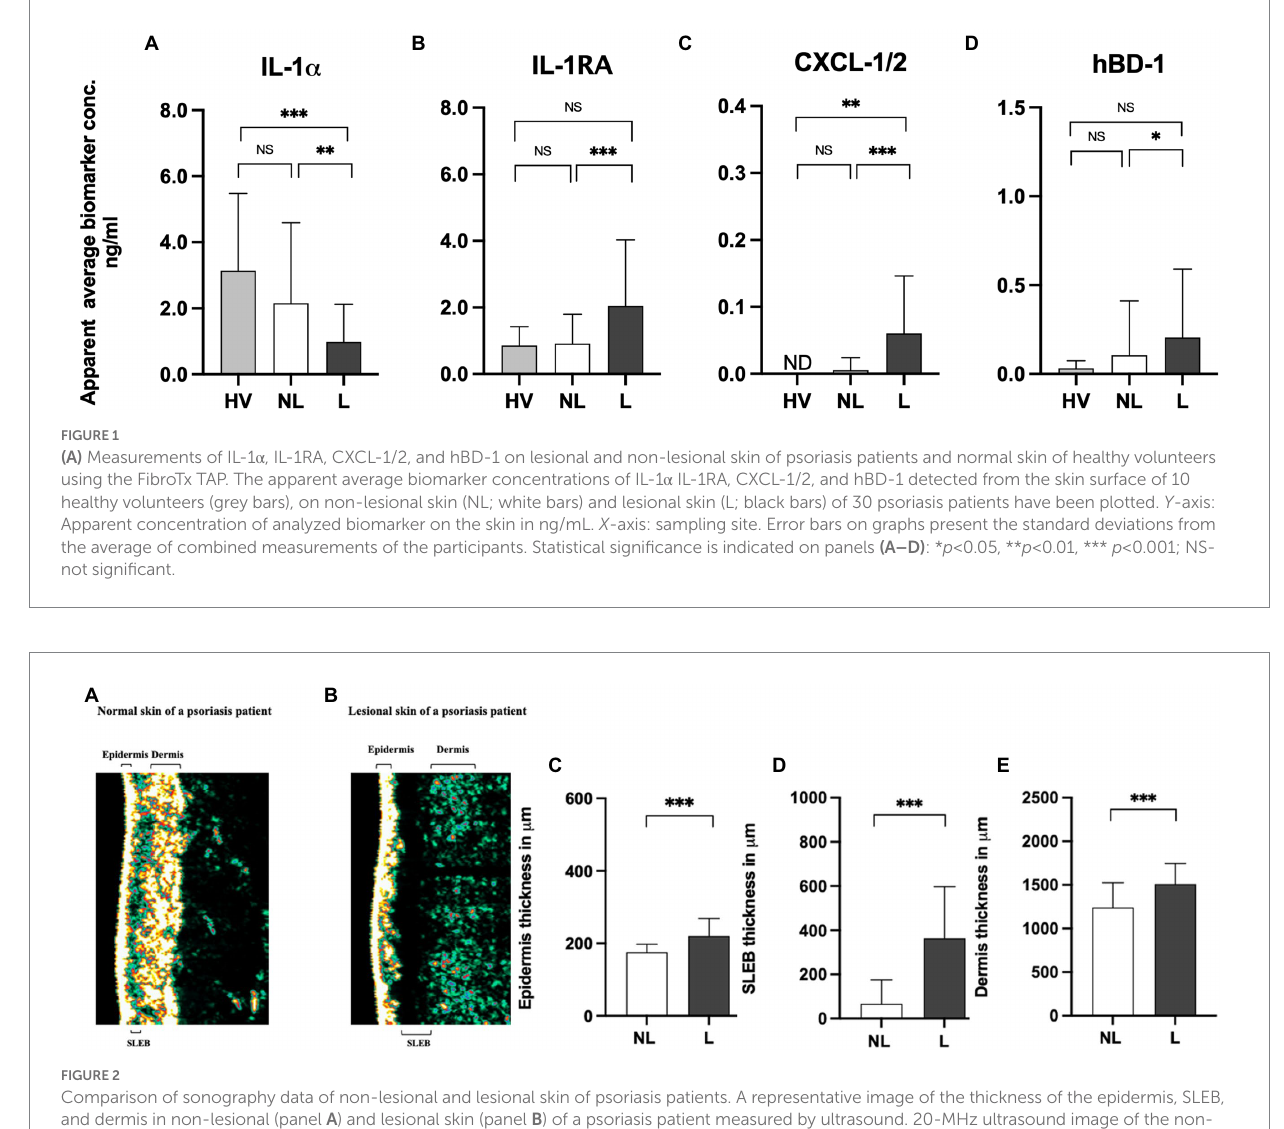
narrow-band UVB treatment, the levels of hBD-1 detected on non-lesional skin increased compared to the baseline with an approximately twofold increase, contrary to the levels of hBD-1 captured on lesional skin, which showed a nearly fourfold decrease compared to the amounts of baseline hBD-1 (Figure 3.). Kinetics of the downregulation of analyzed skin surface proteins showed a notable difference between the individual markers. Levels of IL-1 α displayed a slower response reaching just 40% of reduction whereas IL-1RA and CXCL-1/2 were reduced by 75% and hBD-1 by 80% of their baseline levels on lesional skin after four weeks of treatment (Figure 3B).